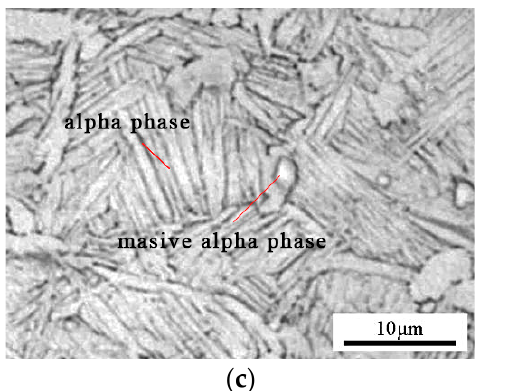
Figure 9. The microstructure of each characteristic zone of weld joint is ( a ) weld zone, ( b ) coarse grain zone, ( c ) fine grain zone, and ( d ) transition zone, respectively.